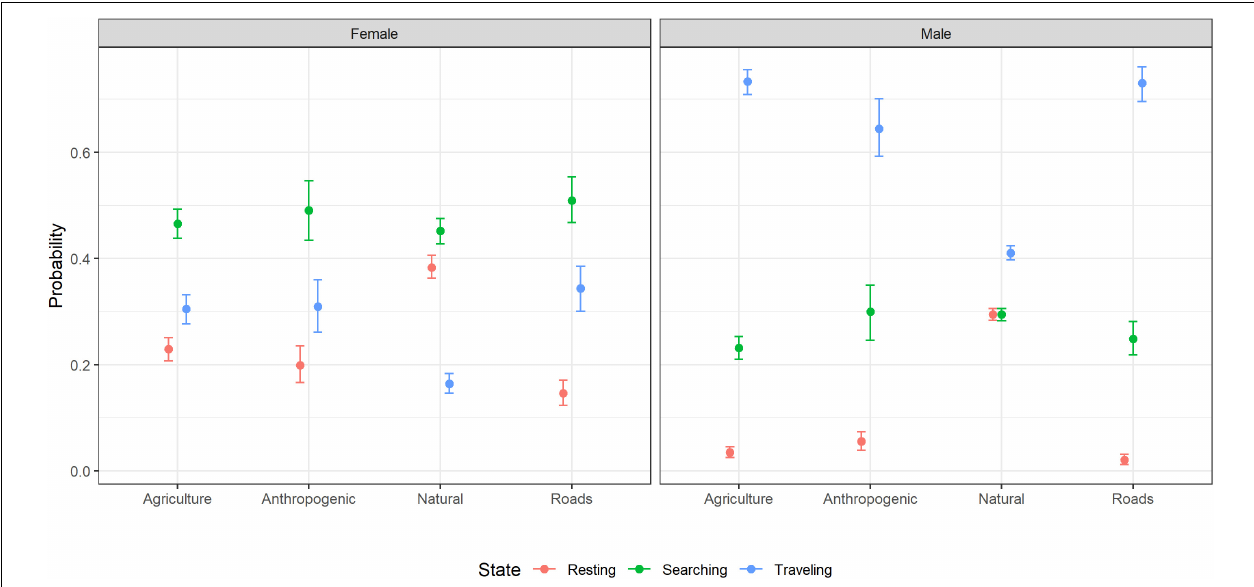
FIGURE 4 | The probability of male and female striped hyenas being in each behavioral state as a function of land cover in the Central District of Israel estimated using multinomial logistic regression. Points indicate the MLE and error bars indicate 95% confidence intervals.